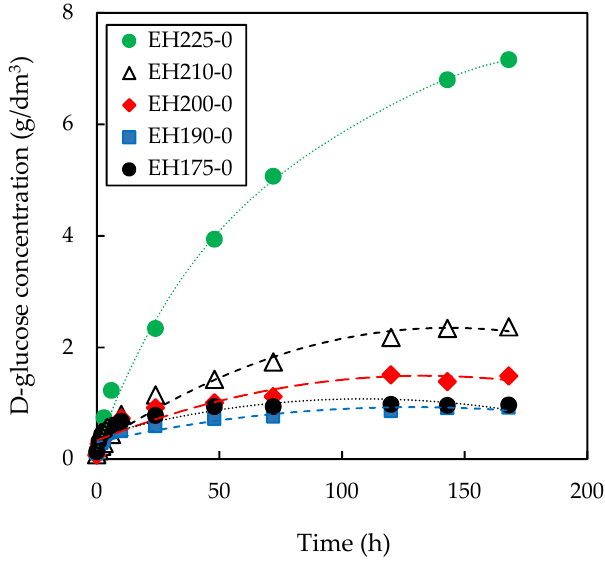
Figure 2. Evolution of the D -glucose concentration in the enzymatic hydrolyses carried out on the pre-treated slurries obtained at different temperatures (175 − 225 °C).